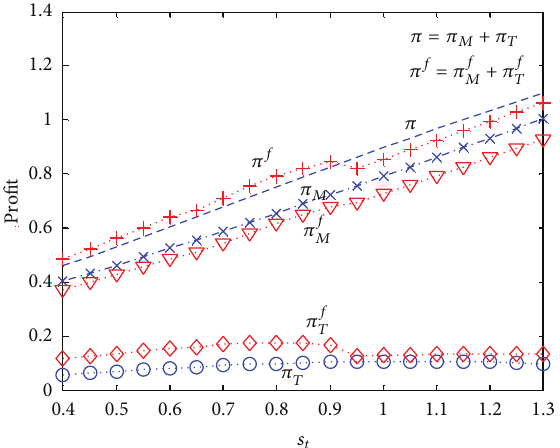
Figure 6: Effect of service level and free-riding on profit.